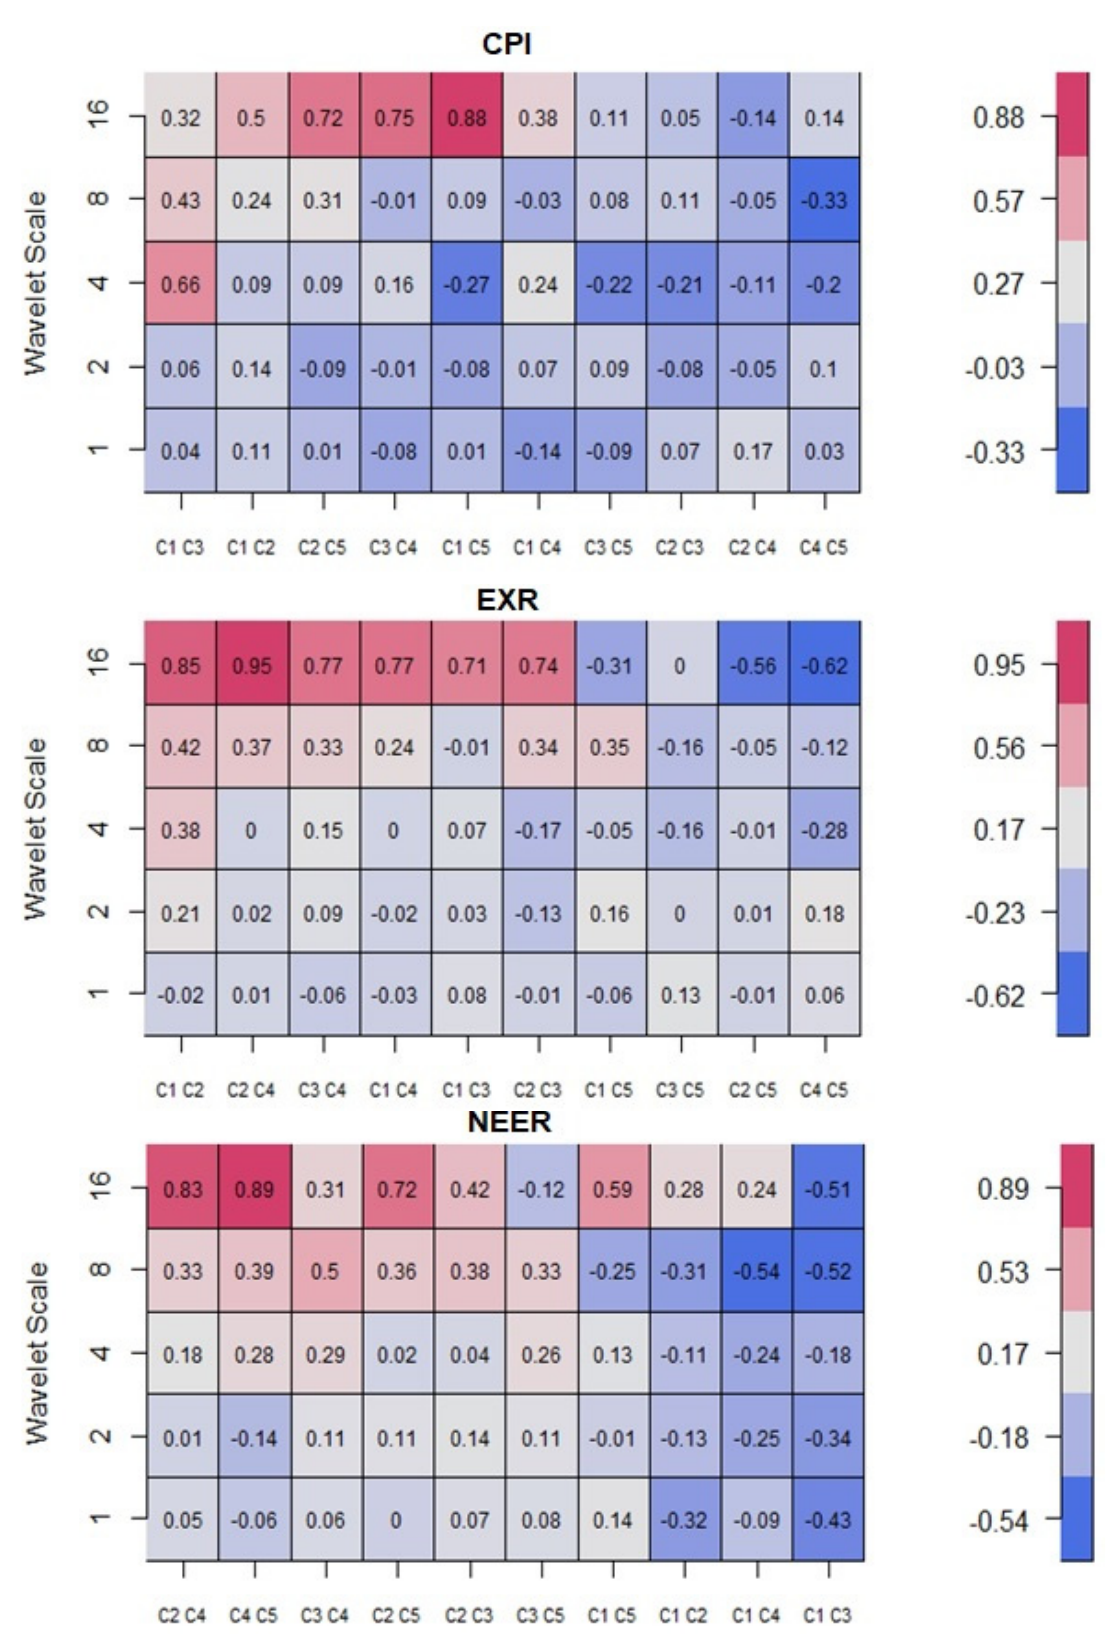
Figure 3. Wavelet bivariate correlations matrix (February 1997 to May 2019). The codes for the variables are Côte d’Ivoire (C1), Gambia (C2), Ghana (C3), Nigeria (C4) and GEPU (C5).